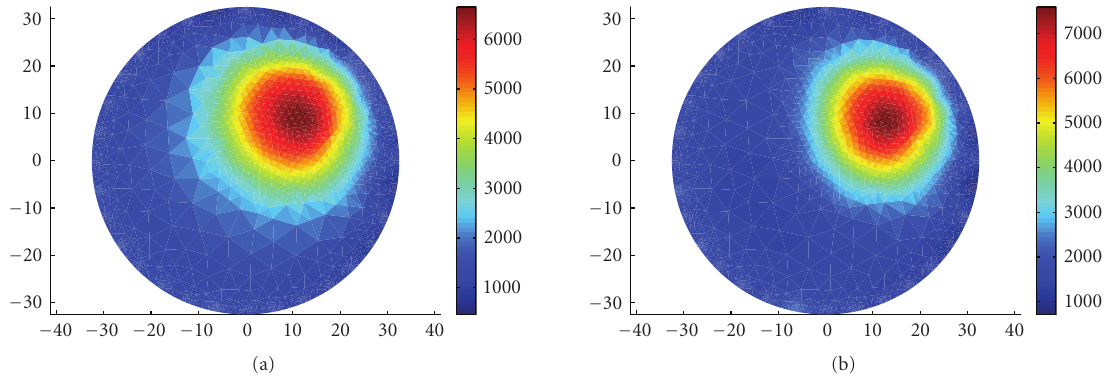
Figure 6: FDM EIT reconstruction of a glass disk in a circular saline tank. (a) FDM measurements. (b) Emulation results. The scale shows the impedance in Ω cm.